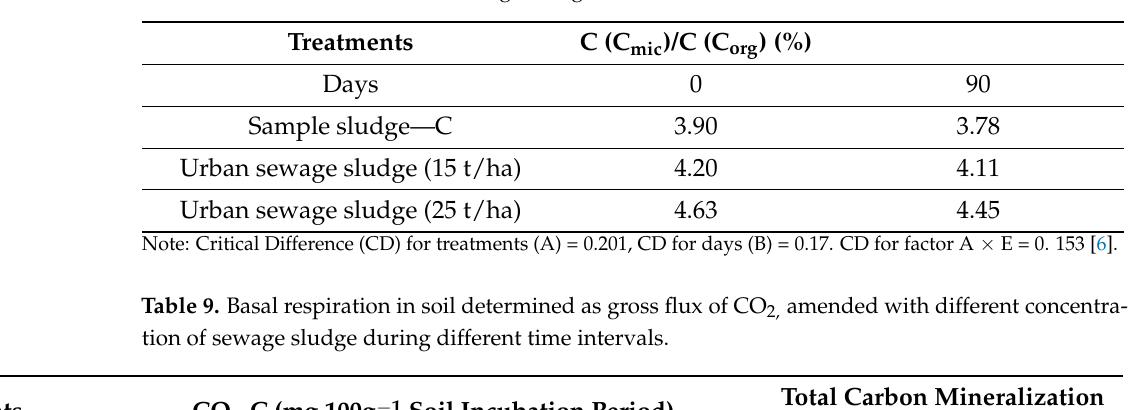
Table 8. Ratio of microbial biomass C (C mic ) to organic C (C org ) or microbial quotient of soil amended with different concentration of sewage sludge.